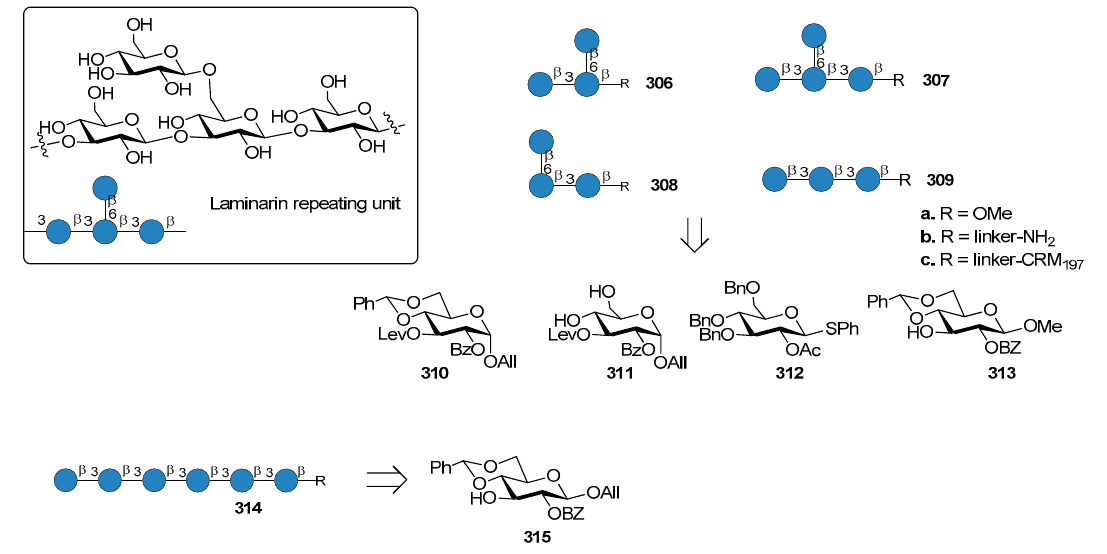
Figure 33. Repeating unit of Lamarin (Lam) and Lam fragments reported in [247].